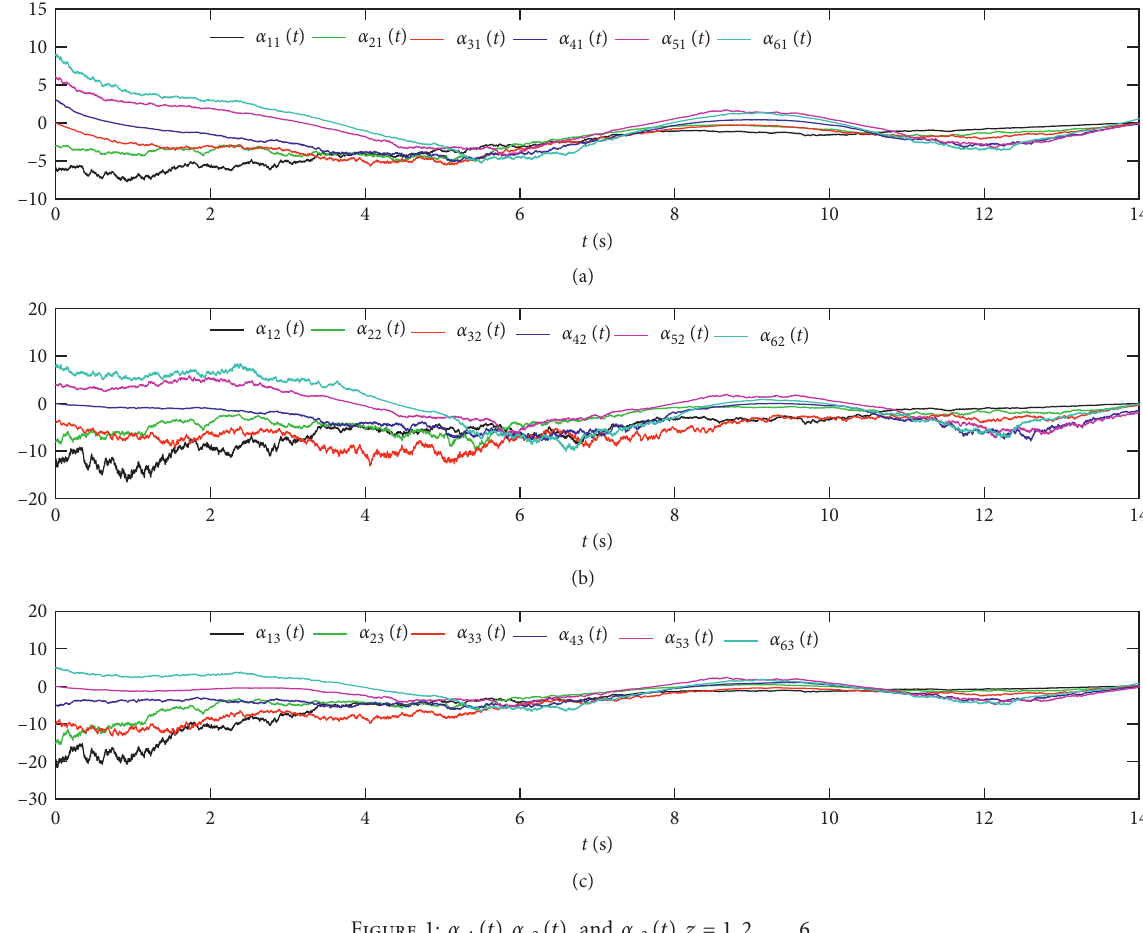
( t ) , α ( t ) , and α z 1 z 2